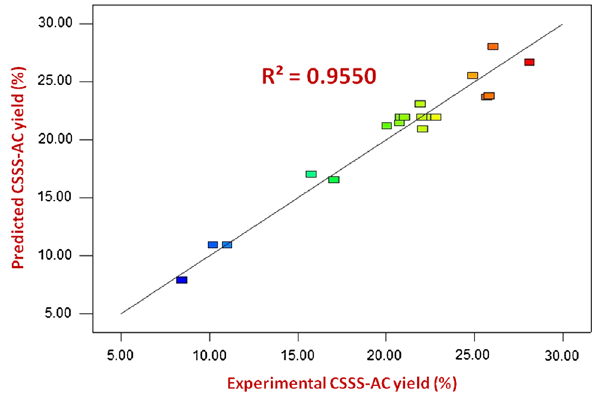
Fig. 3 Relationship between predicted and experimental data of CSSS-AC yield